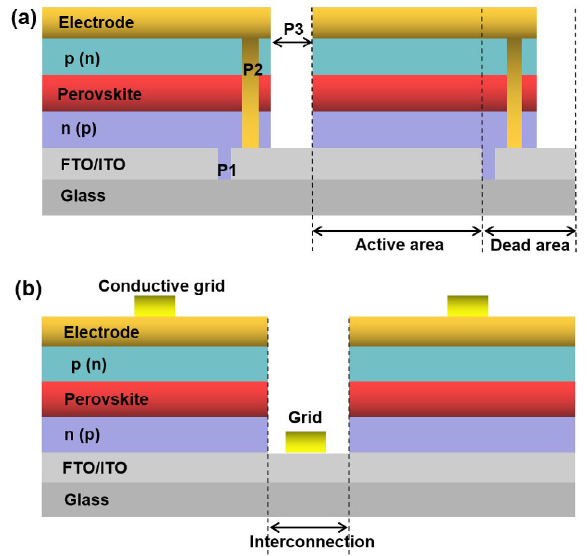
Figure 9 Cross-sectional schematic diagrams of grid lines. The sub-cells are connected in series (a) or parallel (b).